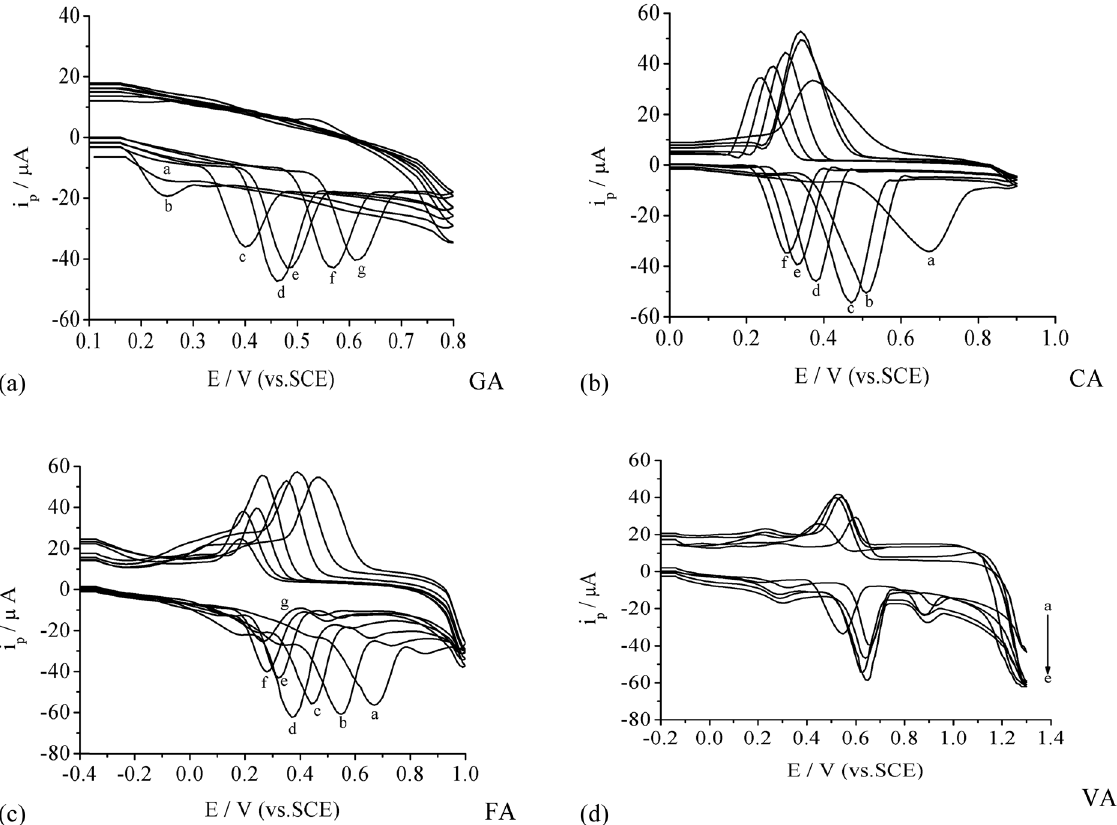
Figure 4: pH e ff ect on the redox peak current of four polyphenolic compounds. ( a (( a ) pH = 7.00, ( b ) pH = 6.00, ( c ) pH = 5.00, ( d ) pH = 4.40, ( e ) pH = 4.00, ( f ) pH = 3.00, and ( g ) pH = 2.20 )) ; ( b (( a ) pH = 3.60, ( b ) pH = 4.00, ( c ) pH = 4.40, ( d ) pH = 4.80, ( e ) pH = 5.40, and ( f ) pH = 5.80 )) ; ( c (( a ) pH = 3.00, ( b ) pH = 4.00, ( c ) pH = 5.00, ( d ) pH = 5.40, ( e ) pH = 6.00, ( f ) pH = 6.60, and ( g ) pH = 7.0 )) ; and ( d (( a ) 400 mmol/L,